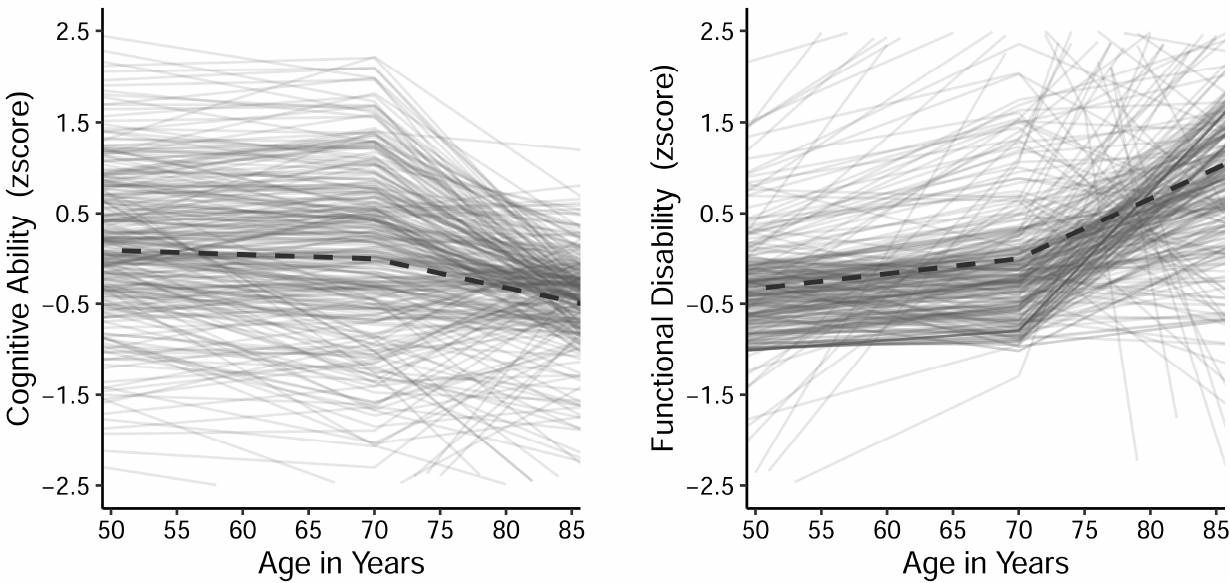
Figure 1. Group average trajectories (dark, dashed lines) estimated from univariate models are shown, accompanied by estimated individual trajectories for a sub-sample of study participants ( n = 300; light-colored solid lines. Trajectories are shown scaled based on the means and SDs at age 70 years.